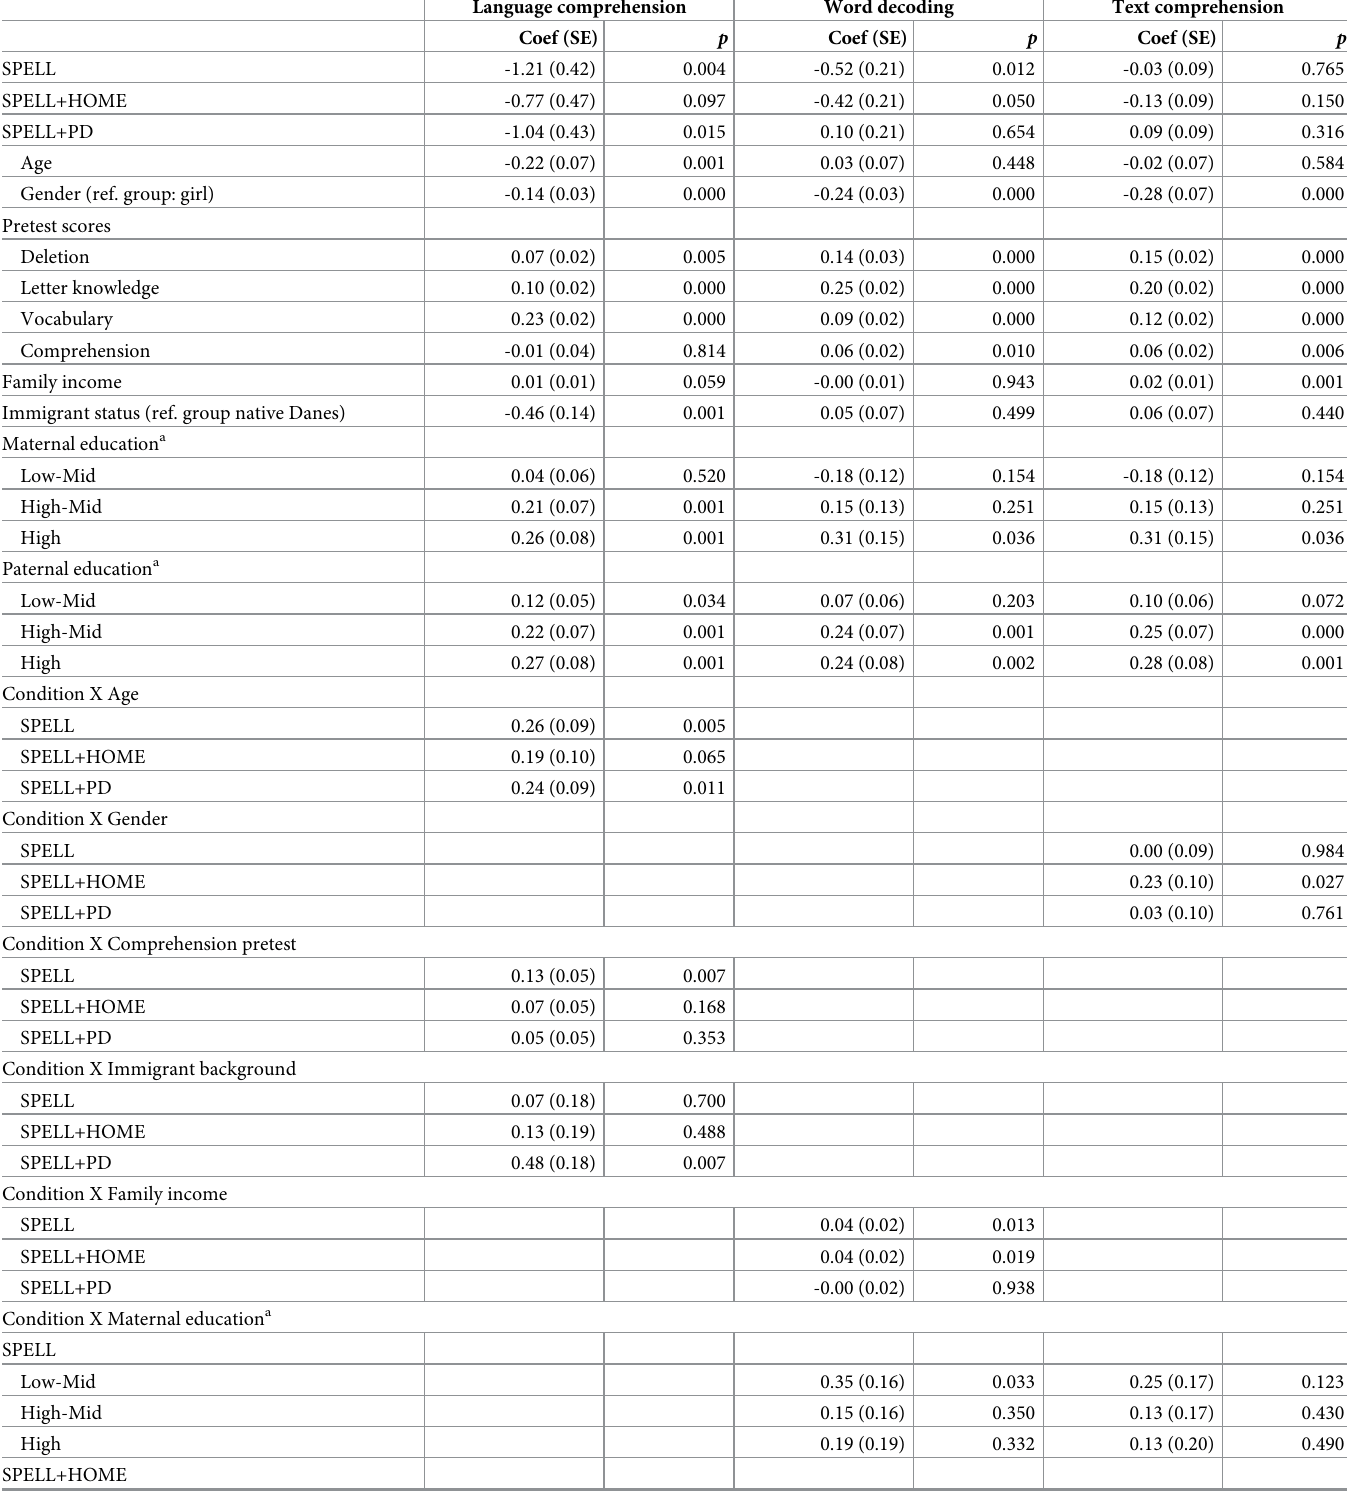
Table 5. Moderation analyses on the three reading scores in second grade for the three SPELL